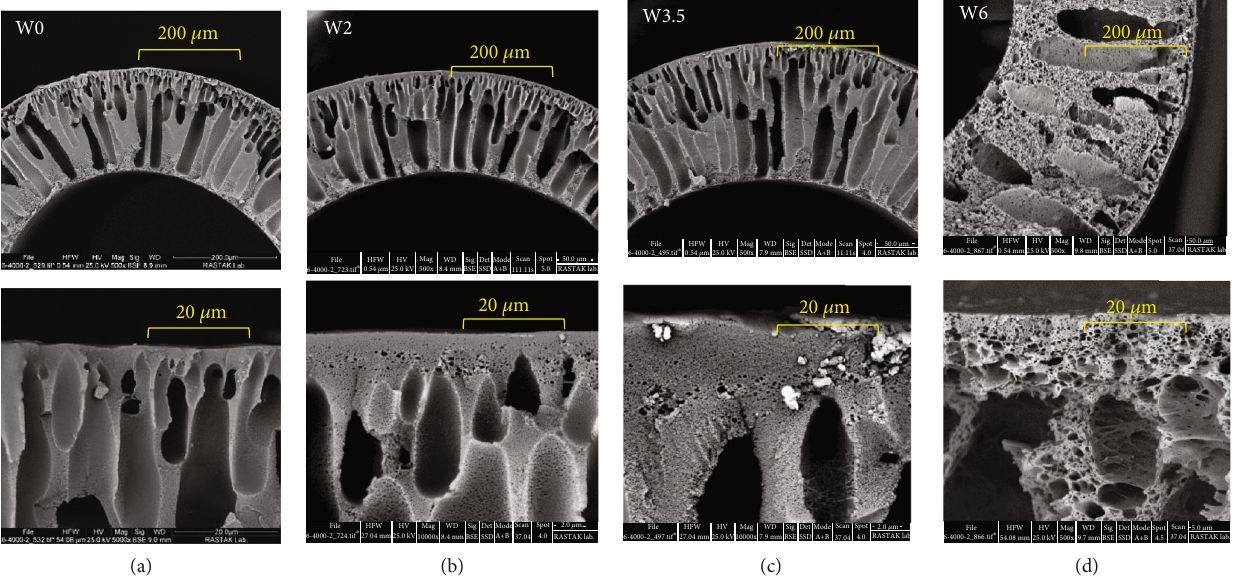
Figure 4: Cross-sectional images of PAN hollow fi ber membranes spun from di ff erent H (d) 6